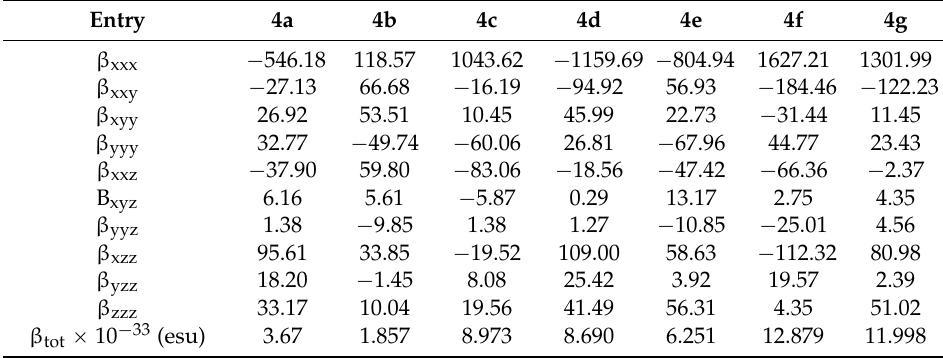
Table 4. First hyperpolarizability parameters of 4a – g .